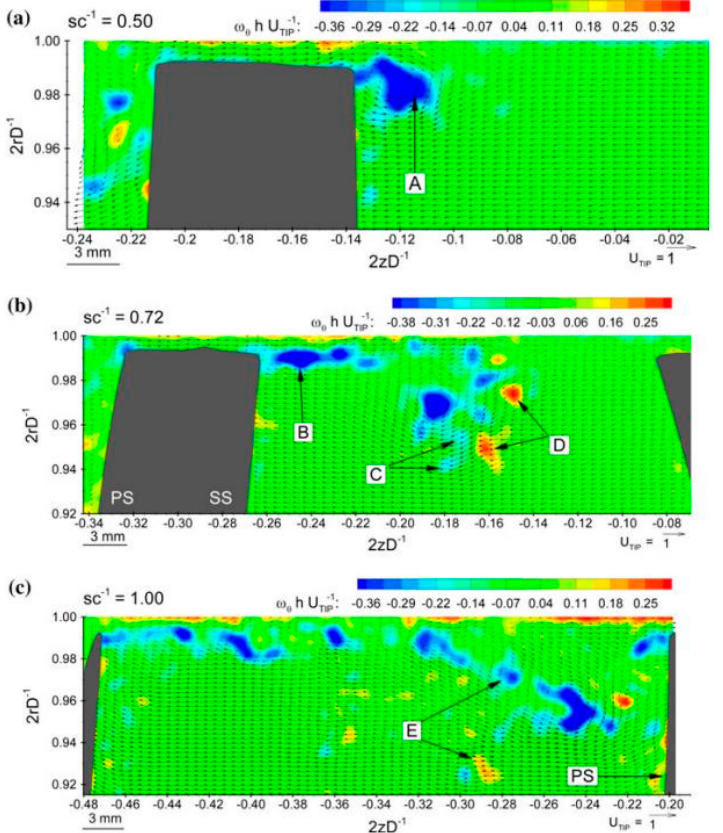
Figure 9. Transient state of TLV distributions at different chord sections [17]. ( a ) sc − 1 = 0.50; ( b ) sc − 1 = 0.72; ( c ) sc − 1 = 1.00. D : casing diameter; h : tip clearance size; ω θ : circumferential vorticity.